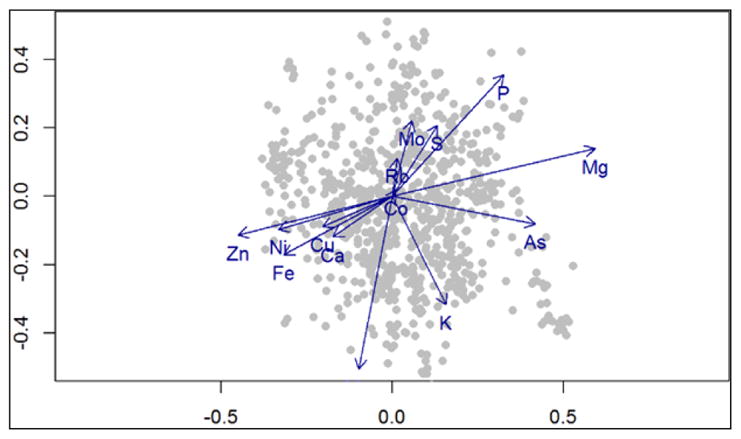
Partial Least Square Regression correlation biplot; plot showing trait components in blue, and markers in gray. Proximity in the graph, such as in the vectors for Ni and Zn, shows that the components are highly correlated. Opposing direction for vectors such as in Zn and Mg, shows that the traits are inversely correlated.